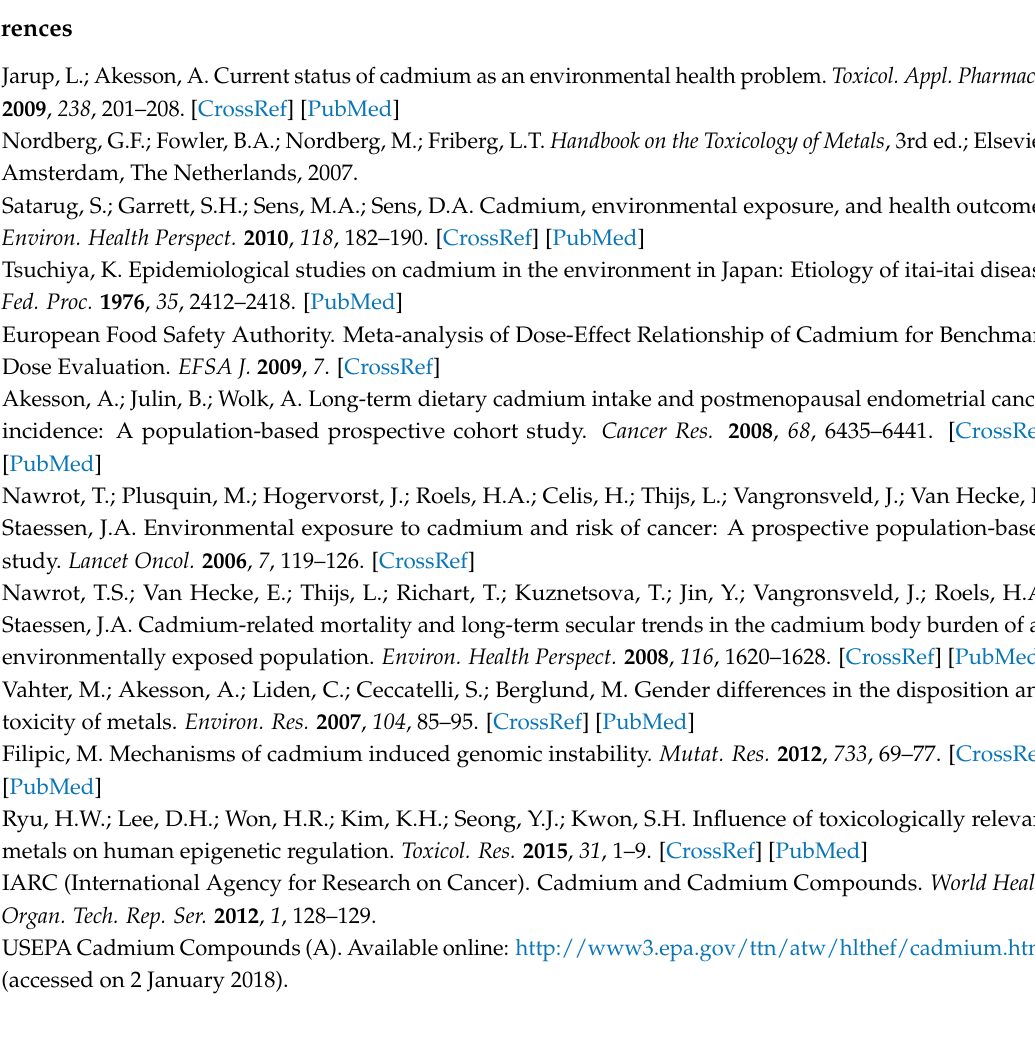
Table S1: Dietary cadmium exposure